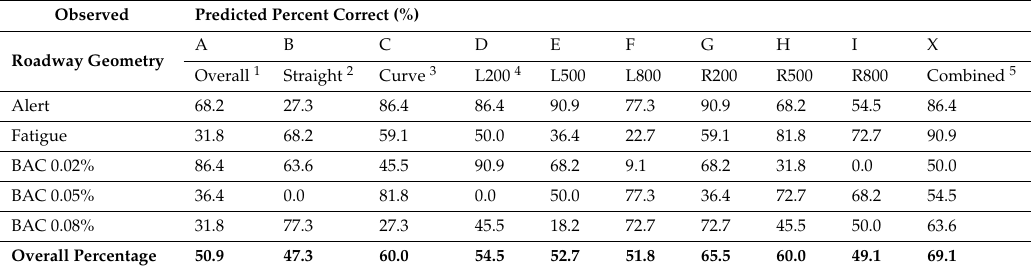
Table 2. Correct percentage of predicted classification of the Classification and Regression Tree (CART) model.